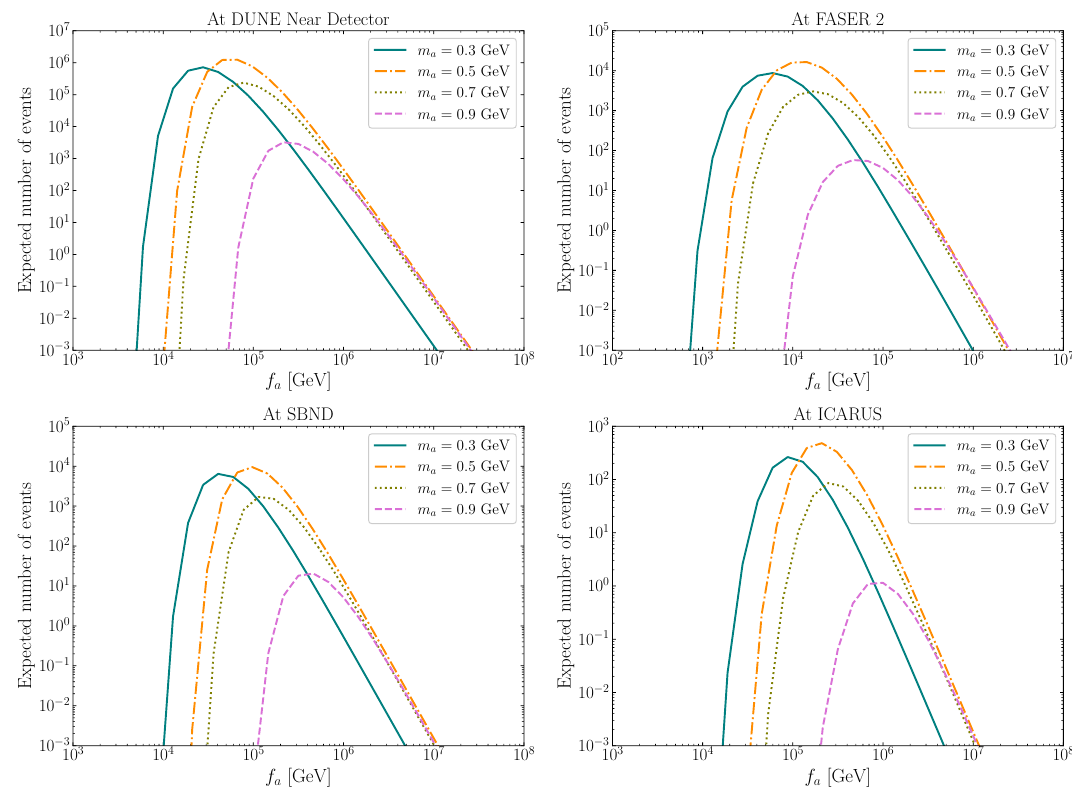
Figure 5 . The expected number of events at DUNE ND, FASER 2, SBND, and ICARUS in which the axion decays into dimuons within the detector, as a function of the decay constant f a . Different curves are for different axion masses m a as labeled. We fix c ‘ = 1 / 36